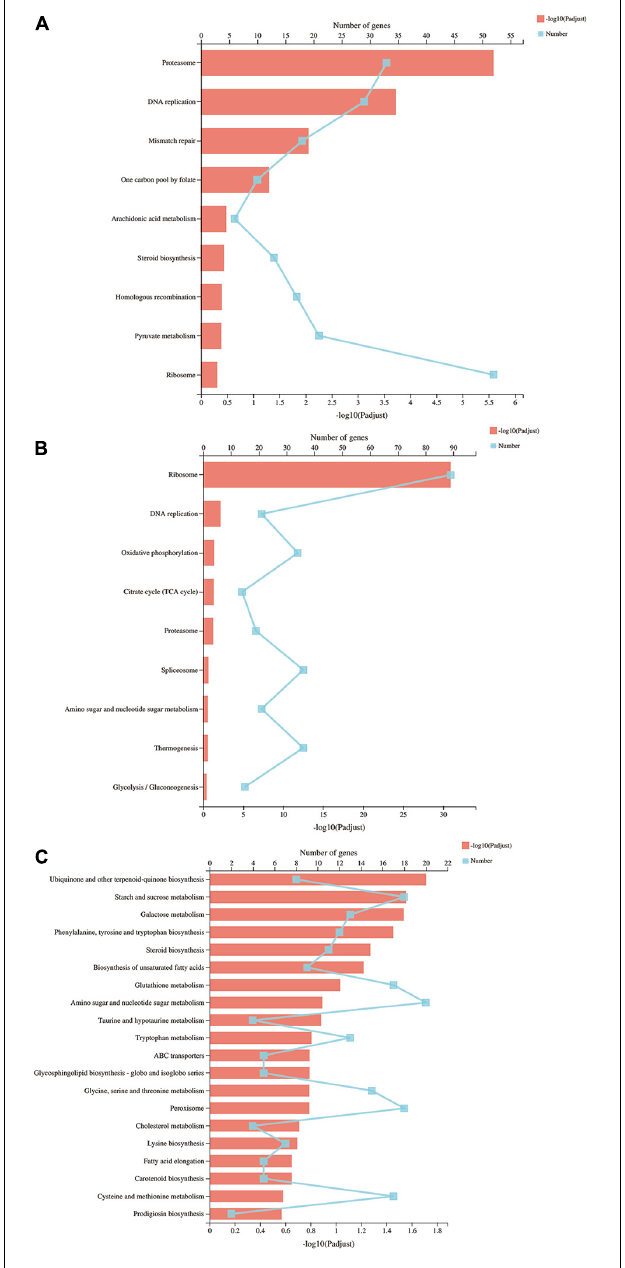
FIGURE 4 | KEGG pathways of differentially expressed genes. The Y axis represents the KEGG pathways, the upper X axis represents the number of DEGs, the basal X axis represents the p -adjusted value, the broken lines represent the number of DEGs in each KEGG pathway, and the bars represent the p -adjusted value. (A) KEGG pathways of differentially expressed genes in the S vs. P comparison; (B) KEGG pathways of differentially expressed genes in the P vs. F comparison; (C) KEGG pathways of differentially expressed genes in the S vs. F comparison.